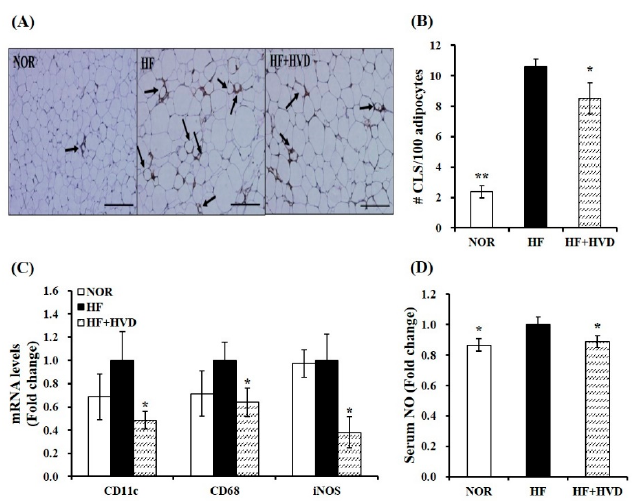
Figure 4. Influence of vitamin D supplementation on adipose tissue macrophage accumulation and polarization in epididymal white adipose tissue (eWAT) of obese mice. ( A ) Representative images of F4/80-immunostained eWAT (scale bars, 200 μ m; magnification, 400×). The black arrows represent a crown-like structure (CLS). ( B ) The mean CLS number was observed under a microscope, quantified from multiple histologic sections, and expressed as CLS number per 100 adipocytes. ( C ) mRNA levels related to M1/M2 macrophage polarization were determined by RT-qPCR, normal- ized to that of β -actin, and expressed as the fold change compared to the HF group. ( D ) Serum nitric oxide (NO) amount was analyzed using a Griess reagent kit and expressed as the fold difference relative to the HF group. Values are expressed as the mean ± SEM ( n = 9/group). NOR, 10% fat diet with 1000 IU vitamin D; HF, 60% fat diet with 1000 IU vitamin D; HF + HVD, 60% fat diet with 10,000 IU vitamin D. * p < 0.05; ** p < 0.01 compared to the HF group.